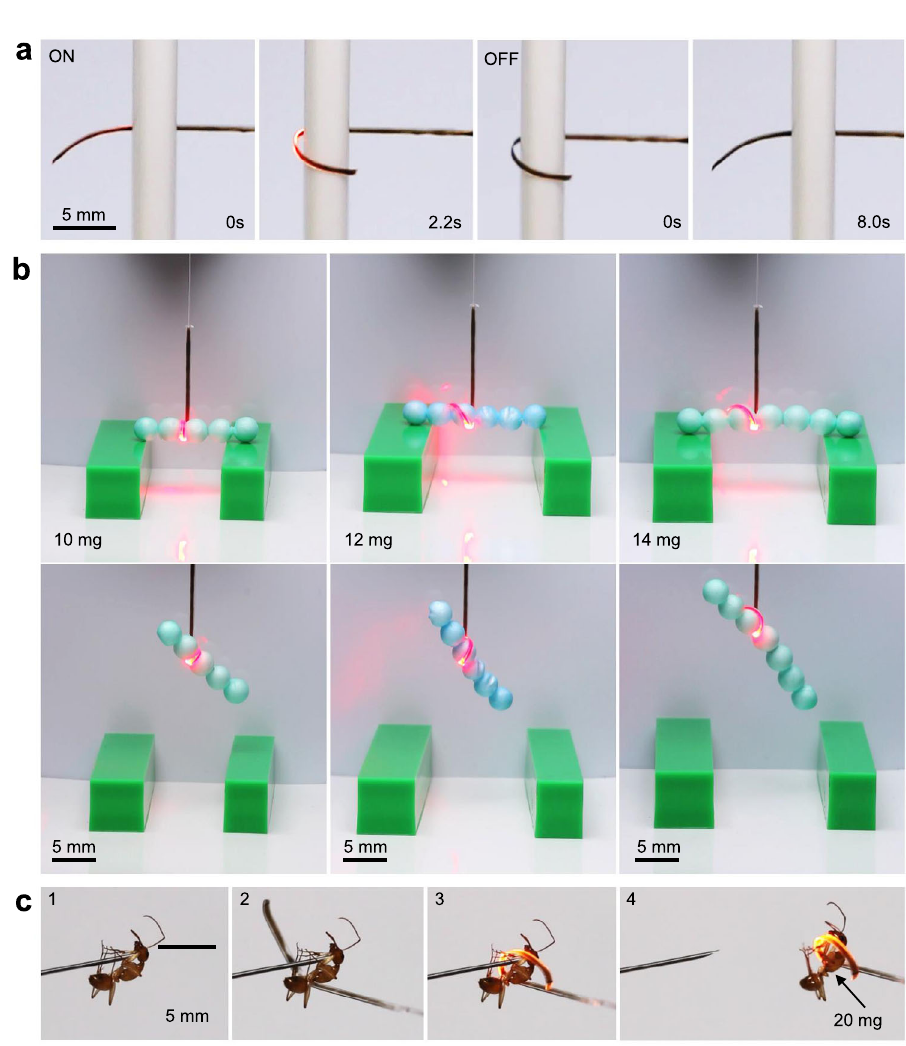
Fig. 4 One-arm OPA gripper captures objects. a Photographs of winding and unwinding a pipe with an OPA. b Photographs of capturing glued balls of different weights with a one-arm gripper. c Photographs of capturing an ant with a one-arm